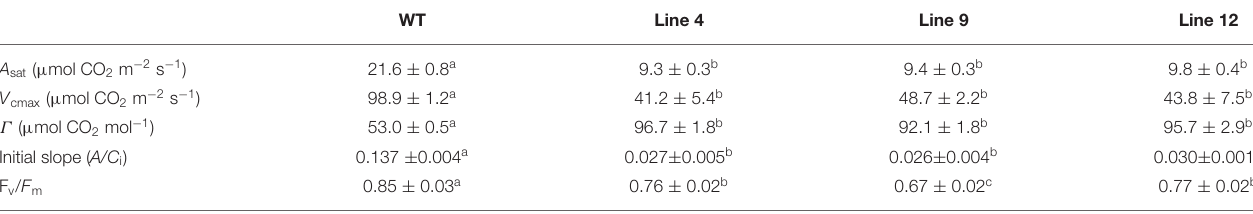
TABLE 3 | Photosynthetic parameters of CRISPR-Cas9 plants with reduced rubisco